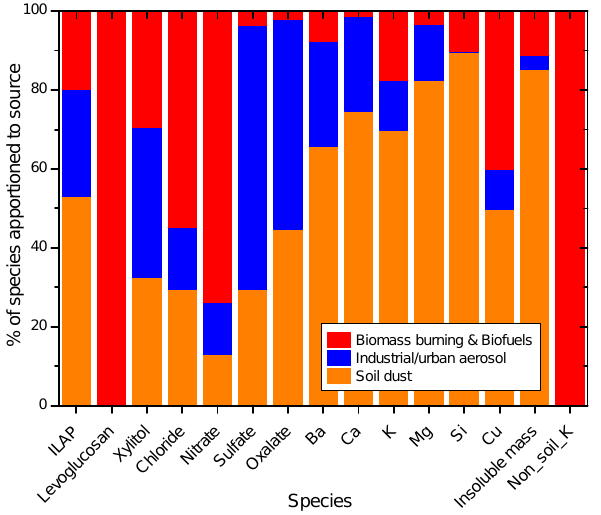
Fig. 3. Factor profiles for the three-factor solution to the PMF in- version of the China snow data set.